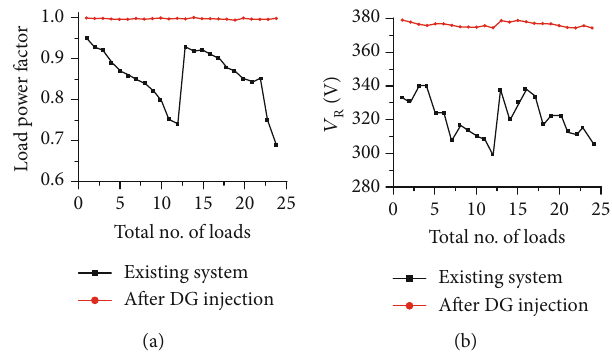
Figure 23: (a) Power factor and (b) voltage at the receiving end in zone